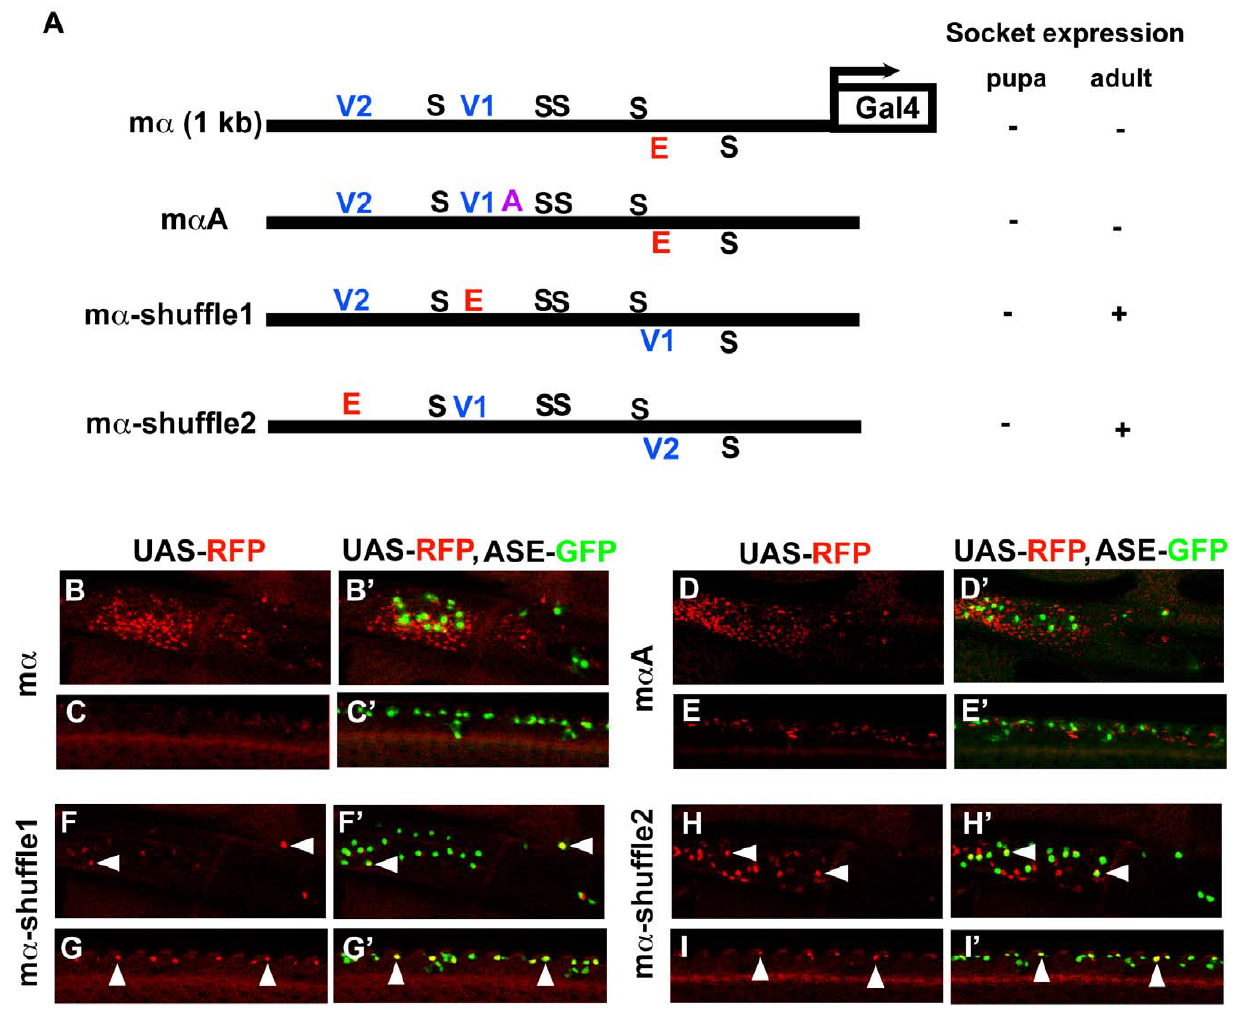
Figure 5. Motif rearrangement in the m a enhancer yields ectopic activity in adult socket cells. (A) Diagrams of the wild-type m a enhancer and variants. The module’s five Su(H) sites (S) are shown in black; the lone ‘‘E box’’ proneural protein binding site (E) is in red; the two Vvl (POU-HD/homeodomain) sites (V1, V2) are in blue; the A motif from ASE5 (AACGCGAAGCT; see Figure 1B) is in purple. Via a three-base mutation, the m a A construct adds the A motif to the otherwise wild-type m a enhancer; m a -shuffle1 and m a -shuffle2 are the same site-exchange variants shown in Figure 4. RFP expression driven by each variant (using the GAL4-UAS system to increase sensitivity) in either nascent (pupa; see Figure 6D–6D 9 and Figure S5) or mature (adult) socket cells is summarized at right. (B–I, B 9 –I 9 ) RFP expression (red) driven by m a enhancer variants in adult wing tissue. Top: Region of the campaniform sensilla cluster at the proximal anterior wing margin. Bottom: External sensory organs at the medial anterior wing margin. In merged images (B 9 –I 9 ), socket cells are identified by expression of an ASE-GFP reporter gene (green) [10]. The wild-type m a enhancer yields only residual RFP expression in surrounding epidermal cells, but not in socket cells (B–C, B 9 –C 9 ). Adding the A motif from ASE5 (m a A) fails to confer socket cell activity (D–E, D 9 –E 9 ), while m a -shuffle1 and m a -shuffle2 both drive reporter expression in some adult socket cells (arrowheads in F–I, F 9 –I 9